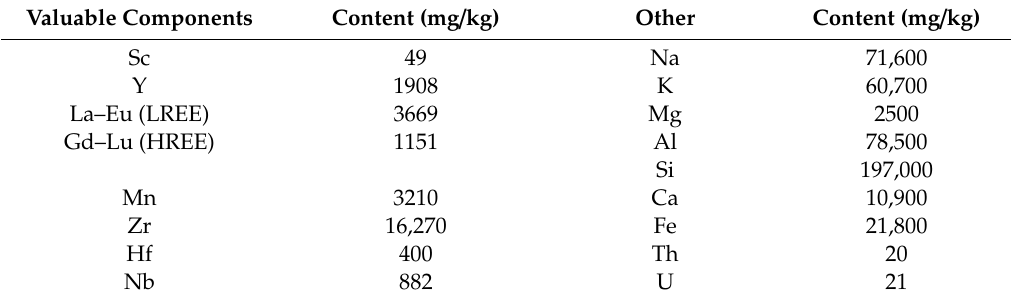
Table 1. The chemical composition of the concentrate determined after lithium metaborate fusion by ICP-OES (Na, Mg, Al, Si, K, Ca, Fe) and by ICP-MS (REEs, Sc, Y, Mn, Zr, Nb, Hf, Th, U). Valuable Components Content (mg / kg) Other Content (mg / kg) Sc 49 Na 71,600 Y 1908 K 60,700 La–Eu (LREE) 3669 Mg 2500 Gd–Lu (HREE) 1151 Al 78,500 Si 197,000 Mn 3210 Ca 10,900 Zr 16,270 Fe 21,800 Hf 400 Th 20 Nb 882 U